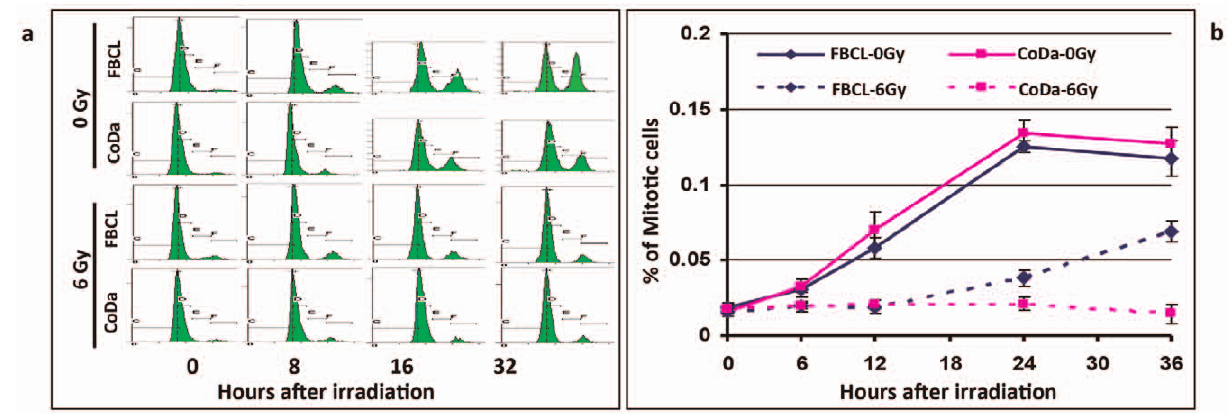
Figure 5. Normal G1/S and G2/M checkpoint activation and impaired recovery from G2 arrest in CoDa cells after irradiation. To assess G1/S checkpoint activation (panel a), cells were treated with or without 6 Gy c -rays and nocodazole was added into medium right after irradiation. Cells were collected for DNA content analysis at 0, 8, 16 and 32 hours after nocodazole added. Shown in panel-a are the histographs of DNA content measured from fibroblasts with 0 Gy and 6 Gy radiation treatment. To measure G2/M checkpoint activation (panel b), cells were treated with or without 6 Gy c -rays and nocodazole was added into medium right after radiation. Cells were fixed at 0, 6, 12, 24 and 36 hours after adding nocodazole. Then immunofluorescent staining was performed with anti-phosphorylated histone-3 (Phospho-H3 at Ser10) antibody. Percentage of